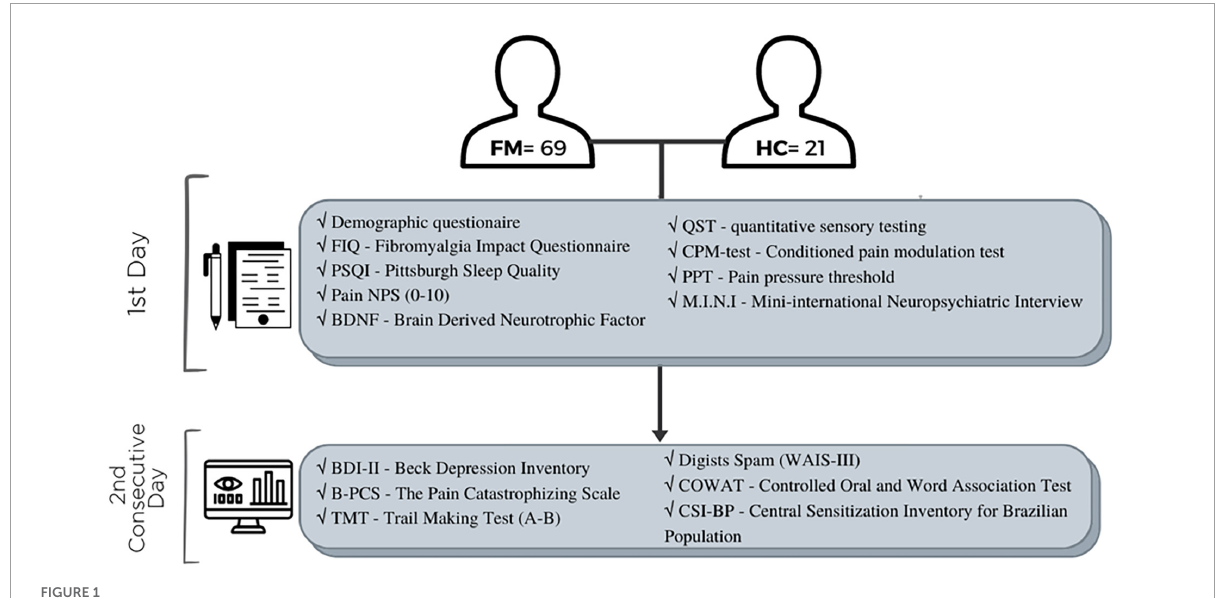
FIGURE1 The sequence of assessments.